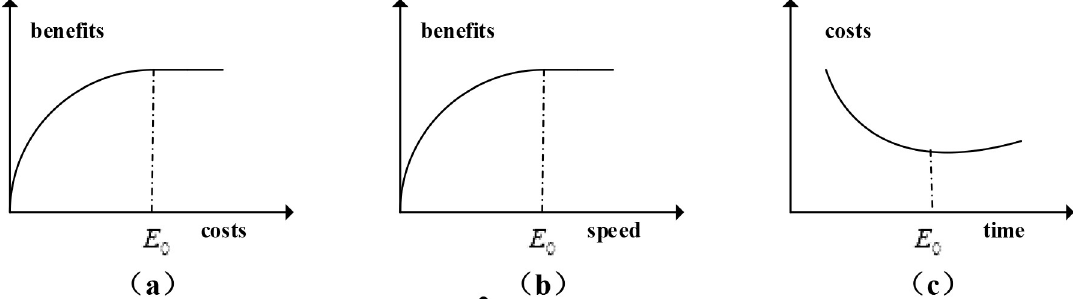
Figure 2. Three elements and their